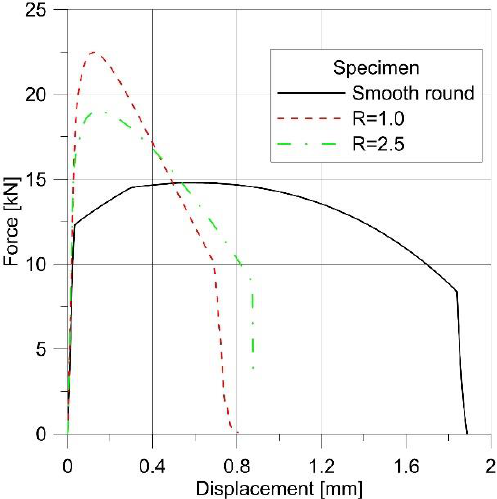
Figure 8. Force–displacement plots for different geometries.